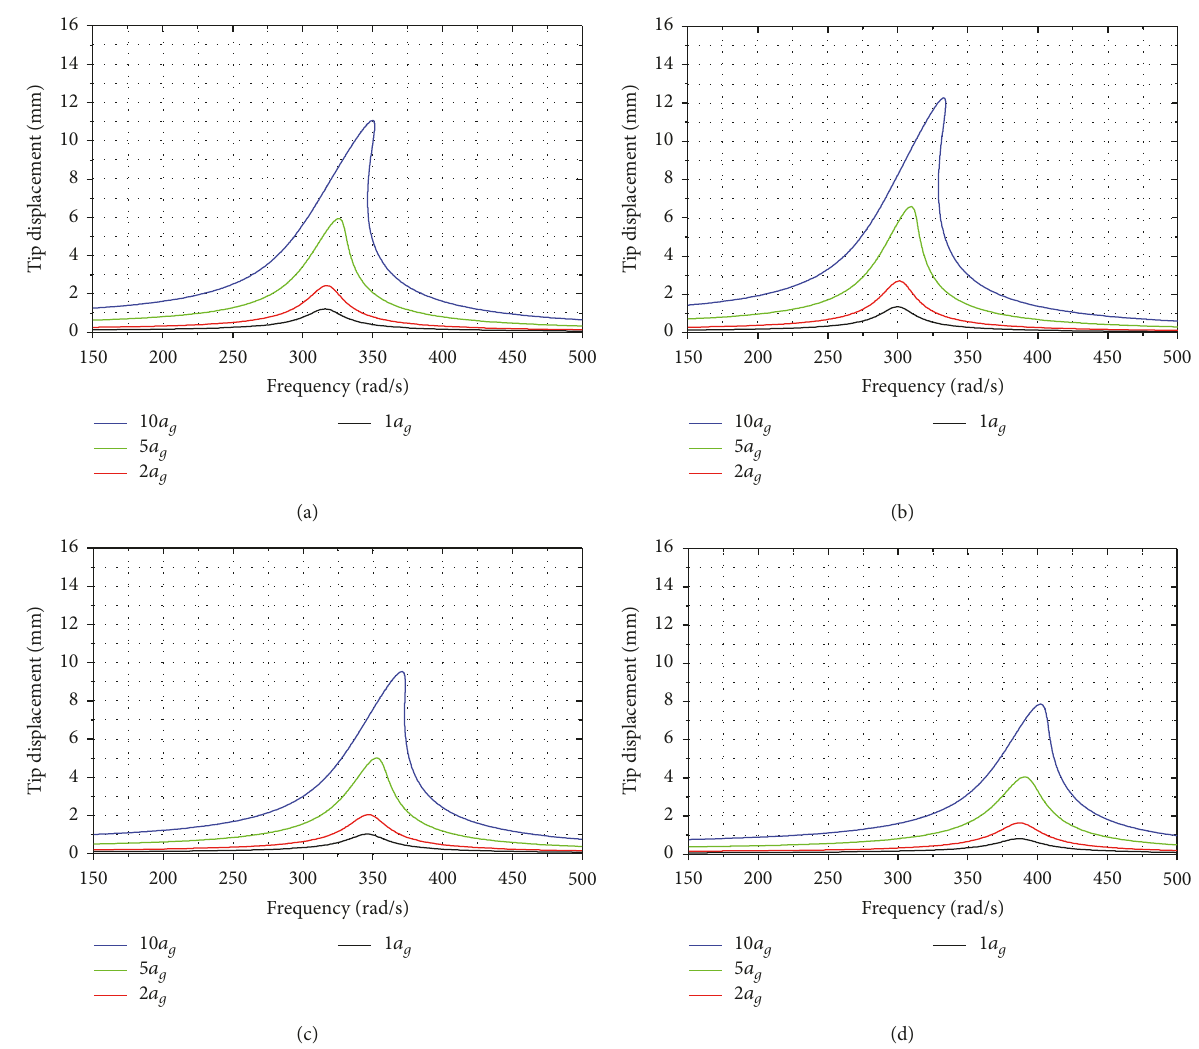
Figure 11: FRFs of the maximum tip displacement for base acceleration amplitudes ranging from 1 𝑎 𝑔 to 10 𝑎 𝑔 , where (a) 𝐸 mylar = 𝐸 0 mylar , (b) 𝐸 𝐸 0 𝐸 𝐸 0 𝐸 𝐸 0 mylar = 0.5 mylar = 1.5 mylar = 2.0 mylar , (c) mylar , and (d) mylar